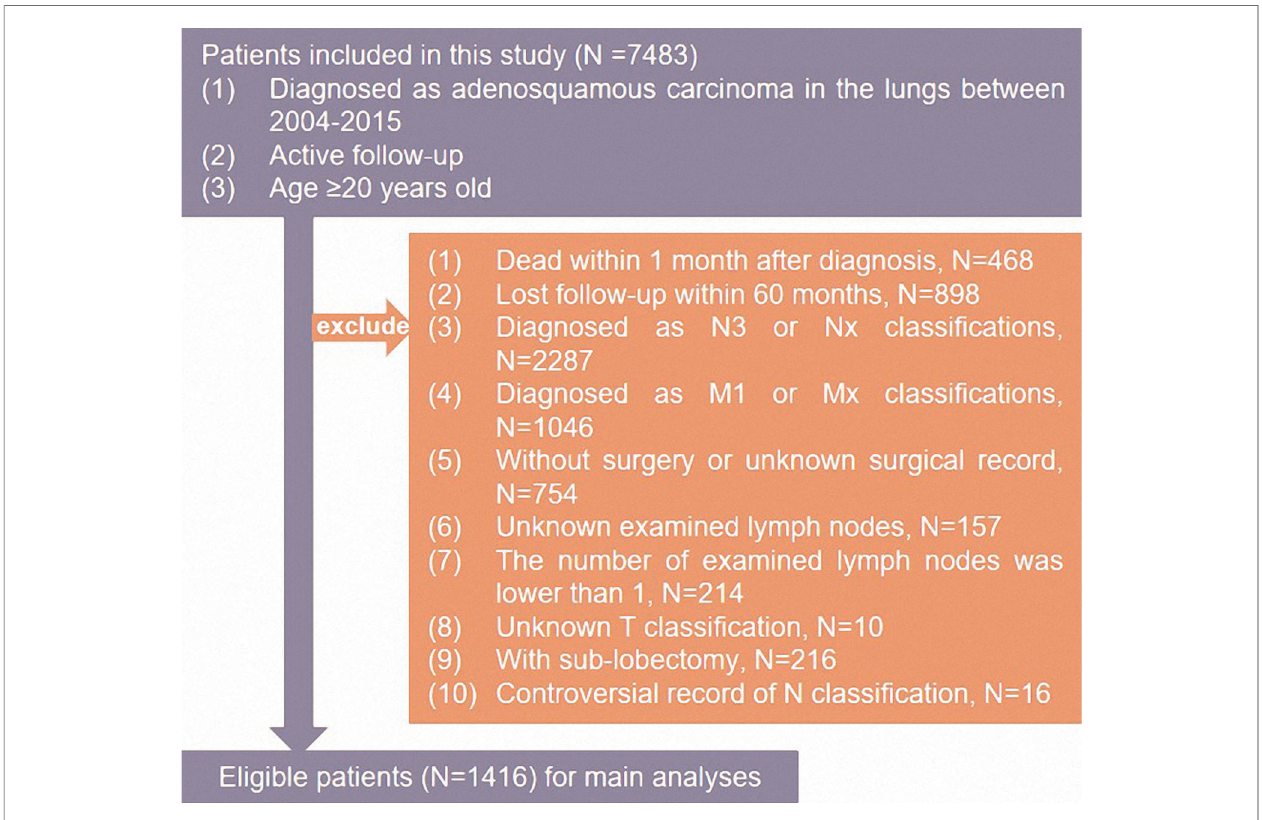
FIGURE 1 | The fl owchart of the